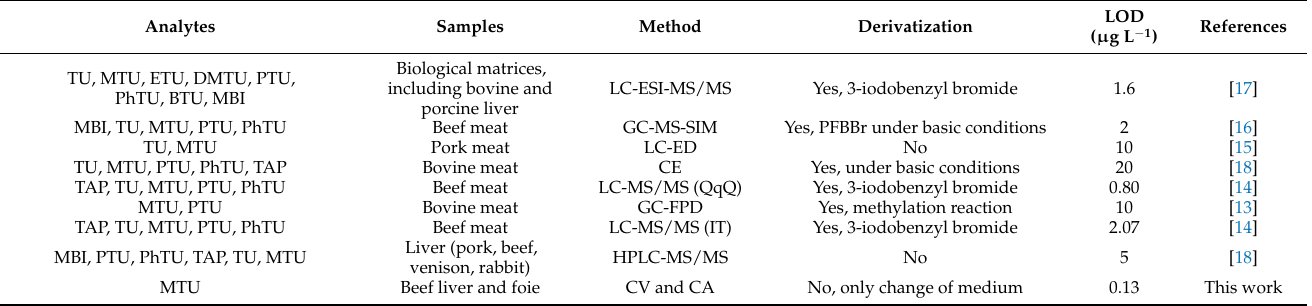
Table 2. Comparative performance of some methods used in the MTU determination in meat samples reported in